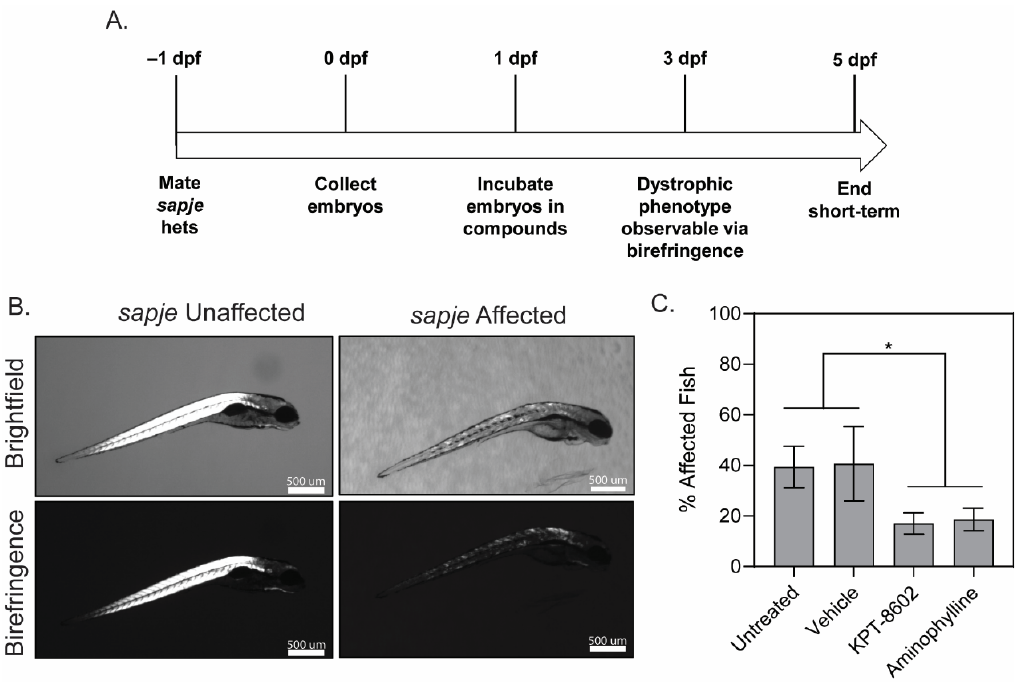
Figure 1. KPT −8 602 improves dystrophic muscle pathology in zebrafish larvae. ( A ) Zebrafish drug dosing timeline; ( B ) Representative images of brightfield and birefringence for both unaffected (WT) and affected ( sapje ) zebrafish larvae. Scale bars represent 500 µm; ( C ) Graph summarizing the birefringence score (in percentage of affected/unaffected over total number of larvae assessed in the clutch) across untreated, vehicle-treated, KPT −8 602-treated and aminophylline-treated (positive control) fish. KPT −8 602 and aminophylline treatment significantly reduced the number of affected fish compared to untreated and vehicle-treated fish (data is represented as mean ± SEM, n = 60 per cohort, across 3 independent trials of n = 20 each; * p < 0.05; one-way ANOVA with Tukey’s HSD test).